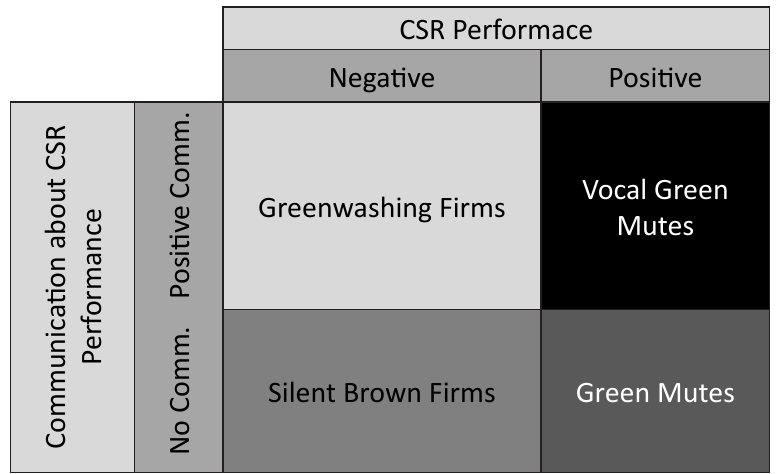
Figure 1. A typology of firms based on CSR performance and communication